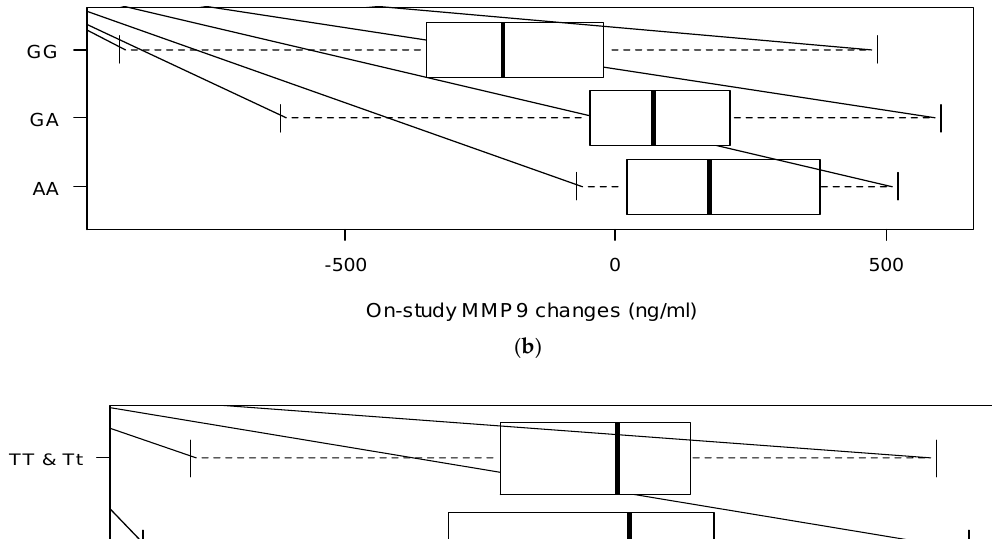
8 of 20 Table 2. Comparison of changes in response variables before and after vitamin D3 supplementation (4000 IU/day) for 12 weeks. Variables